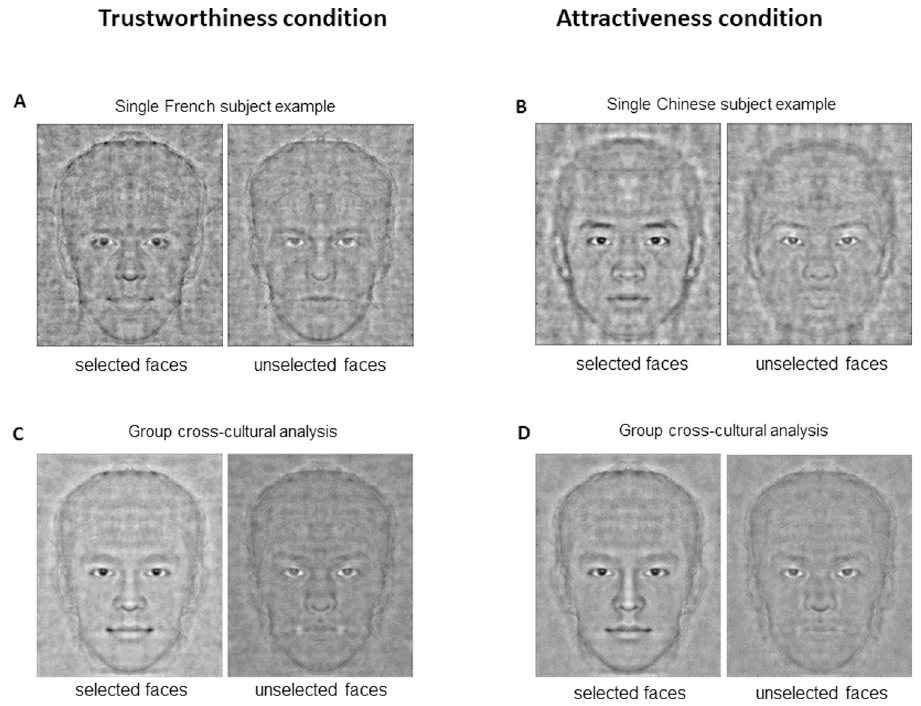
Fig 2. Classification images. Classification images were obtained by averaging the noise patterns selected by the subject and by adding or removing the obtained averaged noise from the original face stimulus. By doing so, the consistently modulated face parts were highlighted. A and B–Single subject classification images. ( A ) Example of a single subject classification image (signal/noise ratio = 1) of one French participant for a judgment of trust on the European descent stimulus. ( B ) Example of a single subject classification image (signal/noise ratio = 1) of one Chinese participant for a judgment of attractiveness on Asian faces. For each participant, the reverse correlation task reveals a picture with important modulations of the facial cues and the face structures of the baseline stimulus, revealing an image of each subject’s internal representation linked to their judgment. C and D–Mean classification images. ( C ) Grand average of all 160 classification images (European and Asian descent faces) obtained from the all 80 participants (French and Chinese) who made trustworthiness judgments (signal/noise ratio = 1/3). ( D ) Grand average of all 160 classification images (European and Asian descent faces) obtained from all 80 participants (French and Chinese) who made an attractiveness judgment (signal/noise ratio = 1/3). By doing so, pixels that are consistently modulated at the population level are highlighted while subject-specific and culture-specific modulations are averaged